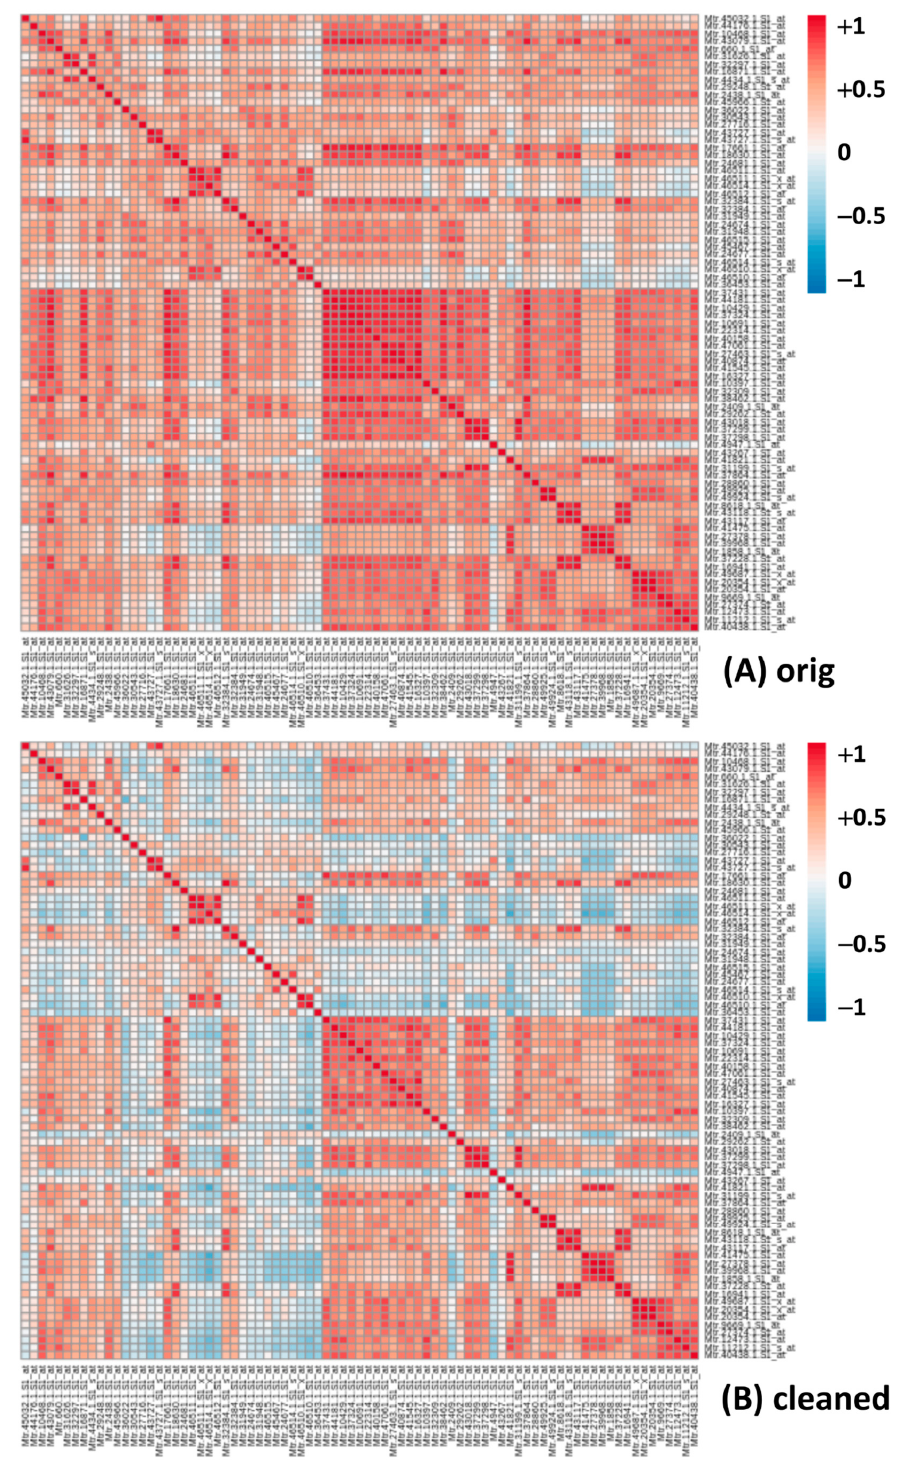
Figure 3. Heatmaps for Pearson correlation coefficients in the logarithmic form for genes of the saponins biosynthetic pathway, with expression values from original ( A ) and cleaned ( B ) Log datasets (Table S12A,B).